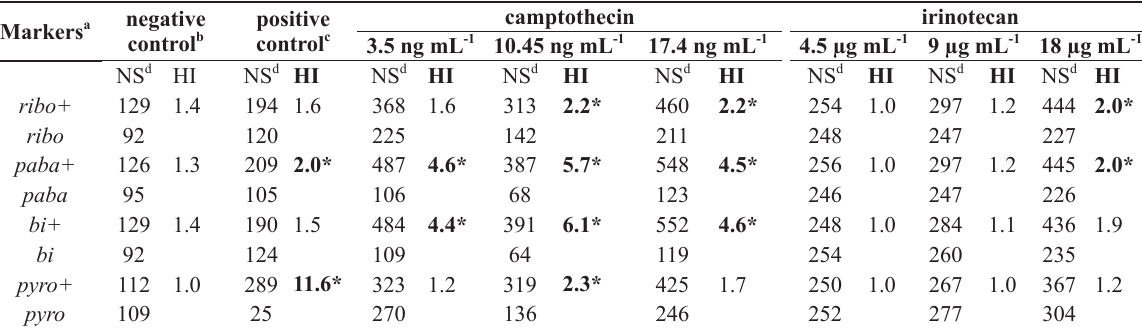
Homozygotization Index (HI) values for markers from UT448//A757 diploid strain after treatment with camptothecin (CPT) and irinotecan